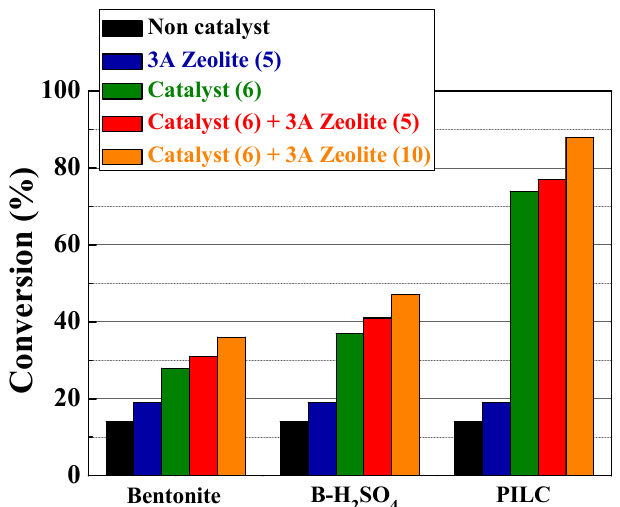
Figure 9. Influence of increasing ratio of 3A zeolite (g/100 g of FACO) on the FACO to esters conversion in the esterification reaction of FACO with EH using PILC. Catalytic conditions: EH:FACO molar ratio of 1.5, reaction temperature: 50 °C, reaction time: 6 h, catalyst to FACO ratio: 6 g/100 g.